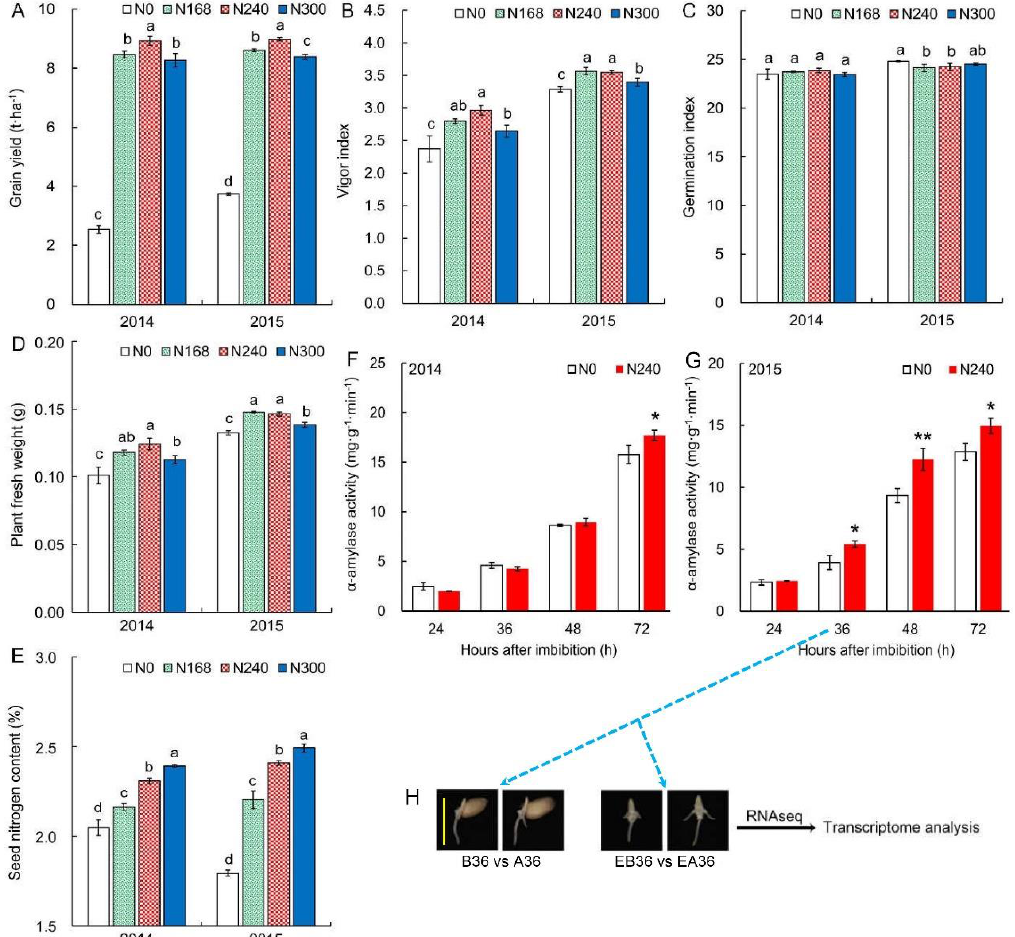
Figure 1. Effects of nitrogen fertilizer on wheat grain yield and seed vigor over two years for four nitrogen fertilizer levels: N0 (0 kg/ha), N168 (168 kg/ha), N240 (240 kg/ha, the usual nitrogen fertilizer level for winter wheat production in the North China Plain), and N300 (300 kg/ha): ( A ) grain yield came from field plot experiment; ( B ) vigor index; ( C ) germination index; ( D ) plant fresh weight came from standard germination test; ( E ) seed nitrogen content; ( F , G ) α -amylase activity under N0 and N240 from 24 to 72 HAI; and ( H ) two kinds of sampling methods in transcriptome analysis. B36 vs. A36: Samples (seeds and seedlings) under N240 compared to those under N0 at 36 HAI. EB36 vs. EA36: Samples (only seedlings) under N240 compared to those under N0 at 36 HAI. Scale bar, 1 cm. Error bars represent the standard deviation for three field plot replicates and each field plot replicate includes at least three technical replicates. Different letters indicate significant differences among means under different treatments ( p value < 0.05 by one-way ANOVA analysis). Asterisks denote a significant difference according to an unpaired Student’s t -test (*: p < 0.05; **: p < 0.01).